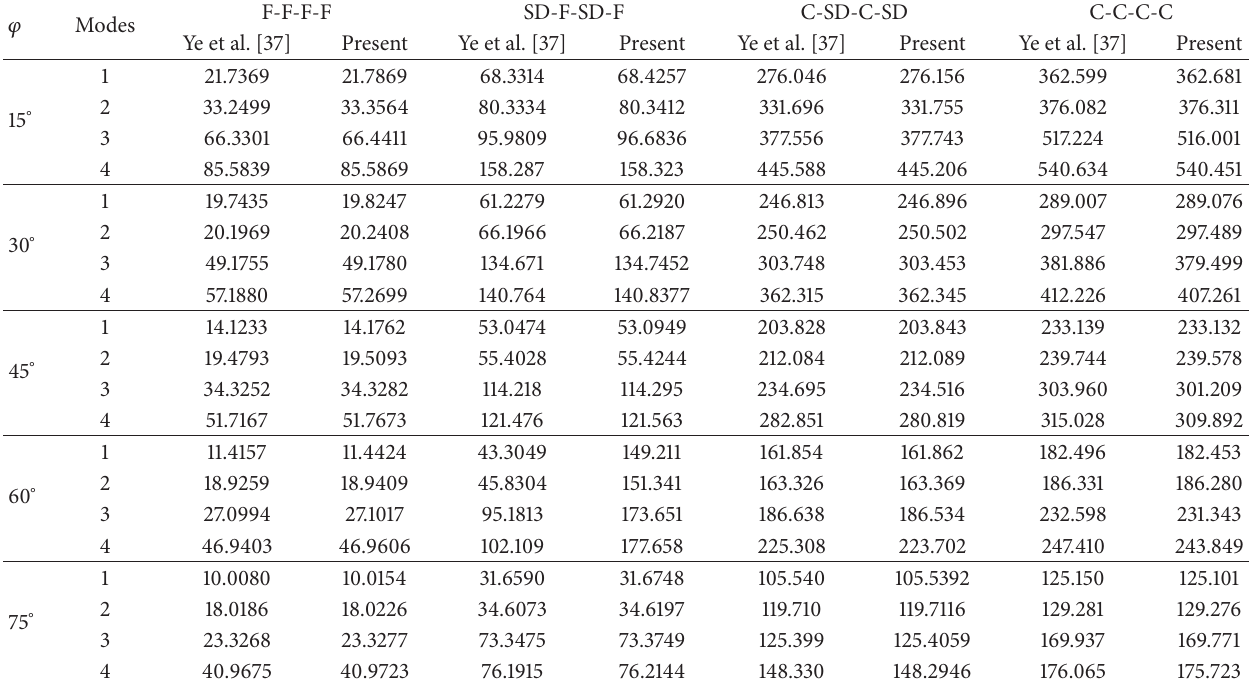
Table 7: First four frequency parameters Ω = 𝜔𝐿 2 √𝜌ℎ/𝐷 for an open conical shell subjected to various cone vertex angle 𝜑 and boundary conditions.